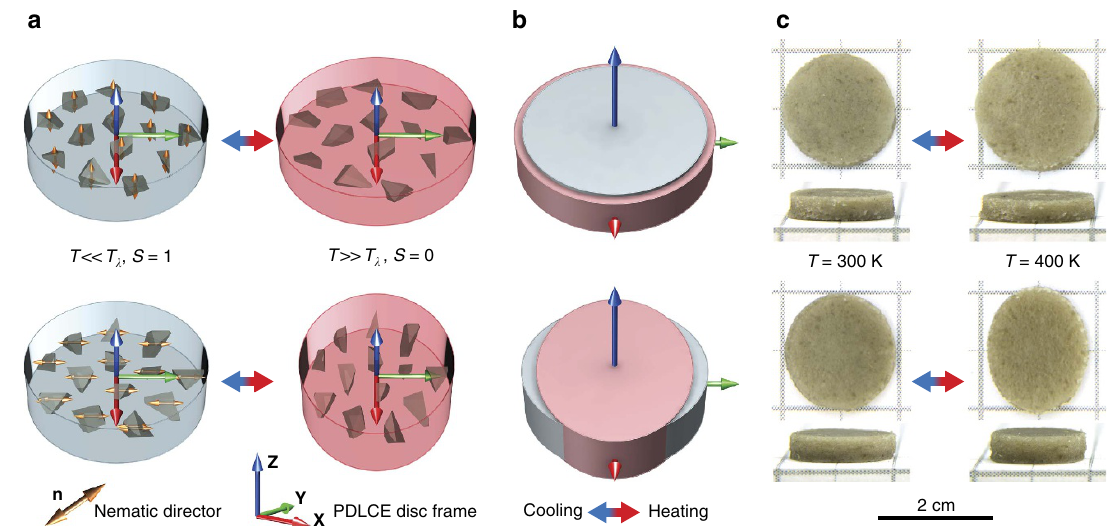
Figure 4 | Morphing behaviour of PDLCEs with uniform LCE microparticle alignment. ( a ) Illustration of thermal actuation of PDLCE disks, their axes of symmetry denoted by Z , with nematic directors n oriented ‘out-of-plane’ (top) and ‘in-plane’ (bottom), that is, with n || Z and n > Z . On heating to T 4 T l (blue-to-red arrow, also for c ), the LCE material becomes isotropic (change of the nematic order parameter S from 1 (large orange double arrow) to 0 (vanishing orange double arrow) accompanied by contraction of m LCE particles along the nematic director n ). The temperature of PDMS matrix is colour-coded in accordance with the colour bar of Fig. 1 (blue-cold, red-hot). Note that S ¼ 1 corresponds to ideal nematic order, never found in a real system. Deuteron NMR, performed on LCE-A with benzene-ring-labelled M4, yields S E 0.65 at T room (ref. 51). ( b ) Macroscopically observed effective thermomechanical response of PDLCE composite: oblate deformation of the n || Z disk (top) and prolate deformation of the n > Z disk (bottom). ( c ) Top- and side-view photographs of n || Z (top) and n > Z (bottom) PDLCE-A disks at T ¼ 300K o T l and T ¼ 400K 4 T l , proving the concept of programmable PDLCE shape memory.